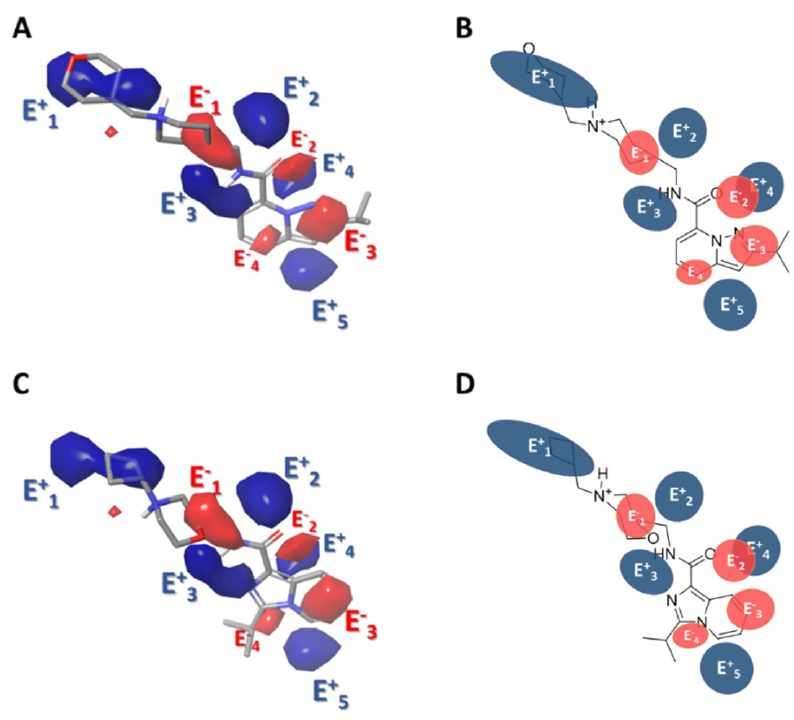
Figure 5. Contour maps obtained for the best Gaussian-based 3D-QSAR model with electrostatic interaction (HD), blue and red regions indicate favorable electropositive and electronegative inter- actions, respectively. Active molecule ( 53 ) is represented in ( A ) (sticks representation) and ( B ) (as draw representation). Less active molecule ( 5 ) is represented in ( C ) (sticks representation) and ( D ) (as draw representation).